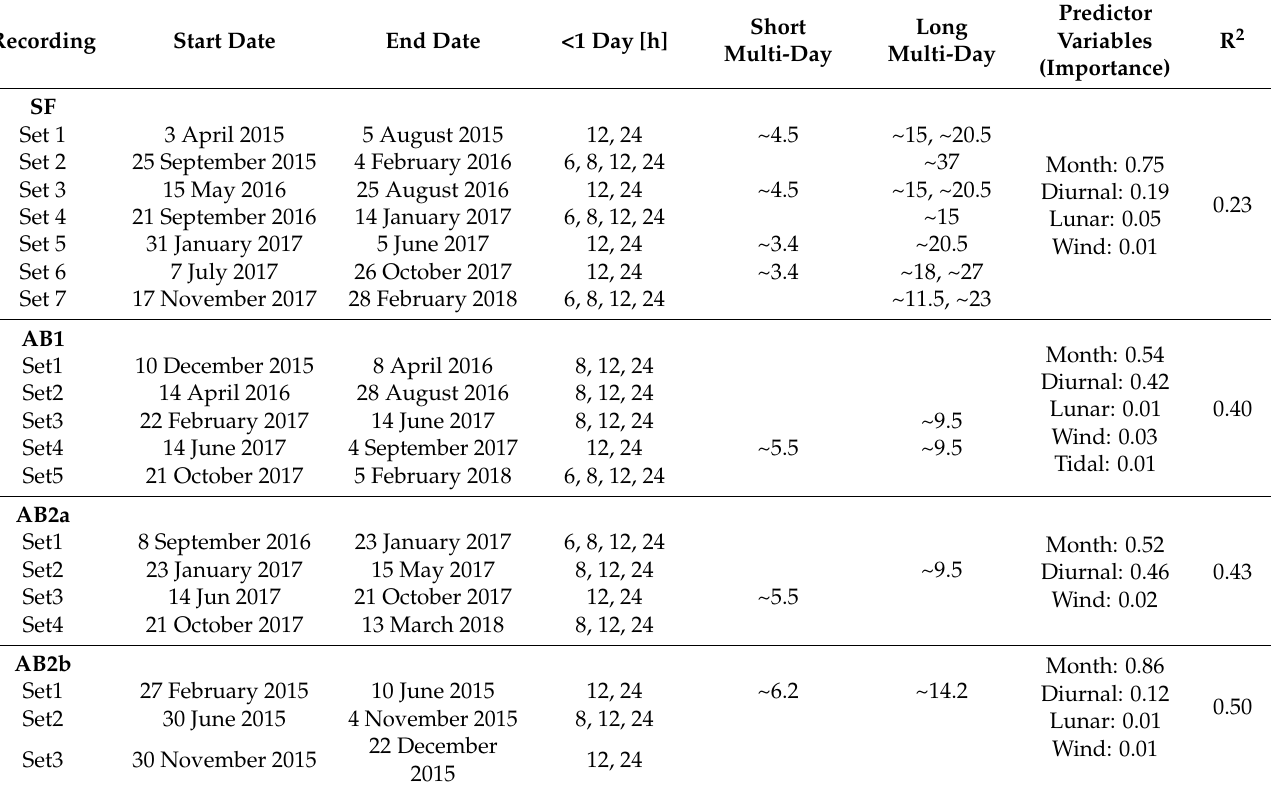
Table 2. Summary of significant periods revealed by periodogram analyses performed on each deployment (columns 4–6) and of variables included in the most parsimonious regression tree for each site. The number behind predictor variables reflects the relative importance of that variable to improving the overall tree prediction error (i.e., root-mean-squared error). R 2 indicates the percentage of variation in the data explained by the regression